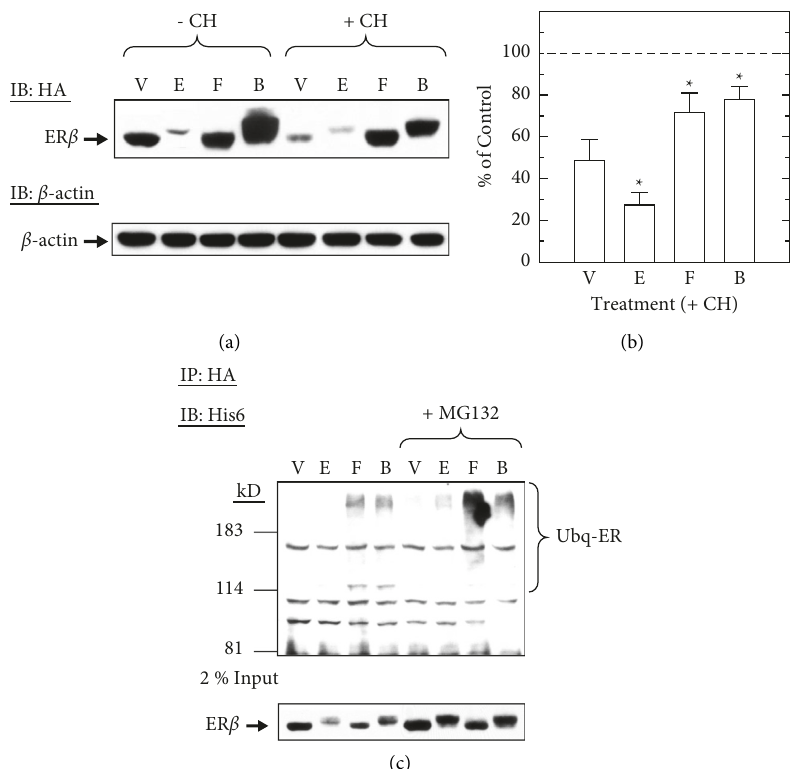
Figure 8: Forskolin protects transfected ER β from ligand-induced degradation and increases ER β ubiquitination. (a) GH3 cells transfected with HA-tagged ER β (400 ng) were pretreated with either vehicle (-CH) or cycloheximide (+CH, 20 μ g/ml) for 30min, followed by vehicle (V), estradiol (E, 10nM), forskolin (F, 1 μ M), or both (B) for 6 h. ER β and β -actin were both detected by immunoblotting (IB) with the antibodies against HA (upper panel) and β -actin (lower panel), respectively. (b) GH3 cells transfected with HA-tagged, ER β were similarly pretreated with cycloheximide and then received either vehicle (V), estradiol (E), forskolin (F), or both (B) and immunoblotted (IB) for HA and β -actin. Relative ER β protein levels (mean ± SEM) were normalized to the levels of β -actin and expressed as a percentage of the untreated control (as 100%, dash line). (c) GH3 cells were transfected with HA-tagged ER β and His6-tagged ubiquitin (2 μ g each) and then pretreated with vehicle or MG132 (40 μ M) for 1h followed by vehicle (V), estradiol (E), forskolin (F), or both (B) for 6h. Cell lysates were immunoprecipitated (IP) with HA antibody and then immunoblotted (IB) for His6 to detect ubiquitinated ER β (Ubq-ER). In parallel, the same lysates (10 μ l each) were immunoblotted (IB) with the HA antibody (lower panel). ∗ depicts significantly altered ER levels or transcriptional activity as compared to vehicle-treated controls (V) ( P < 0 .